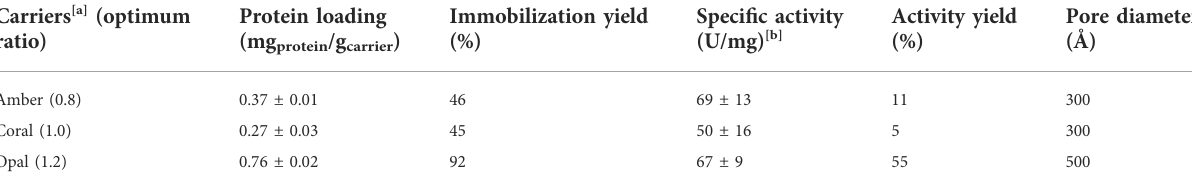
TABLE 3 Screening results obtained for the af fi nity immobilization of puri fi ed his-tagged Aae UPO PaDa-I. Carriers [a]